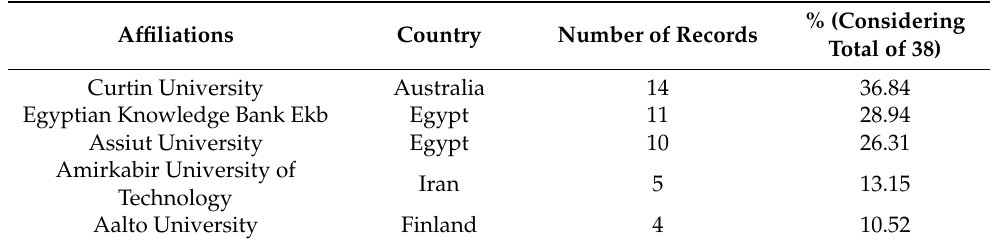
Table 3. Top 6 institutions with the highest number of publications (data from 2018 to